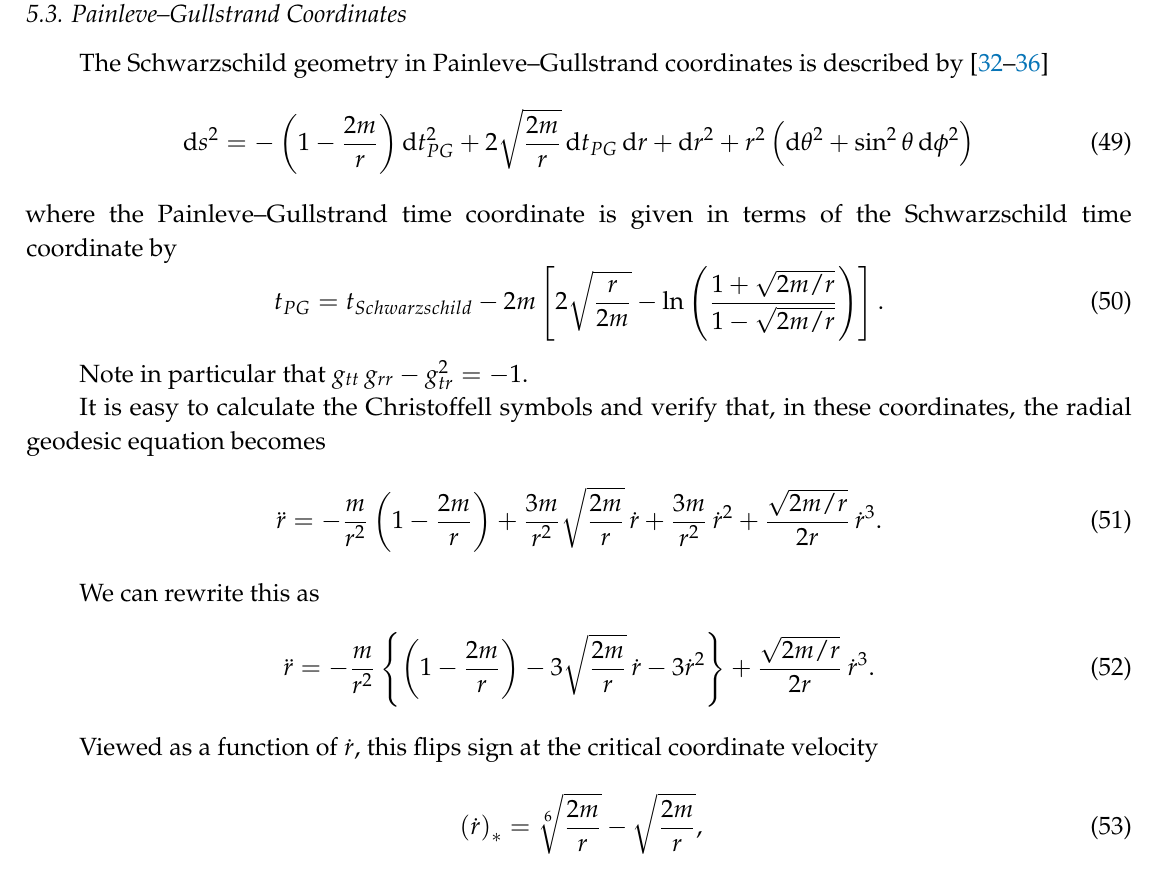
Figure 8. Behaviour of ¨ r for null geodesics in the Schwarzschild geometry using isotropic coordinates for m = 1 and (cid:101) → ∞ . Note the horizon is now at m /2; there is an extra zero at m /4. Note the coordinate acceleration is positive all the way from the horizon to spatial